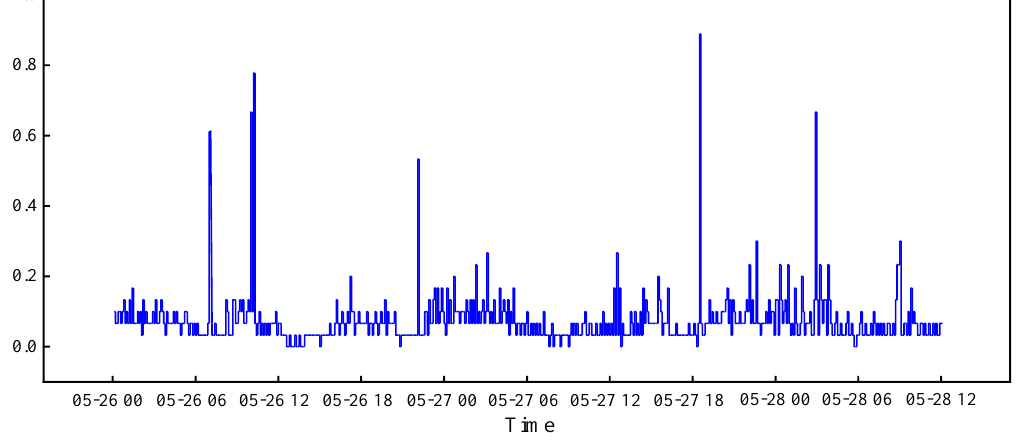
Figure 5. Electricity consumption of 1# workshop.